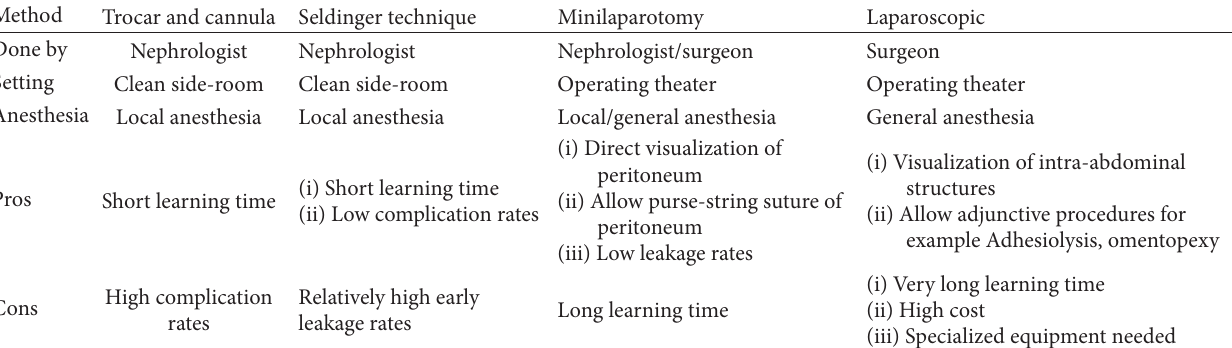
Table 1: Comparison of different methods of peritoneal dialysis catheter